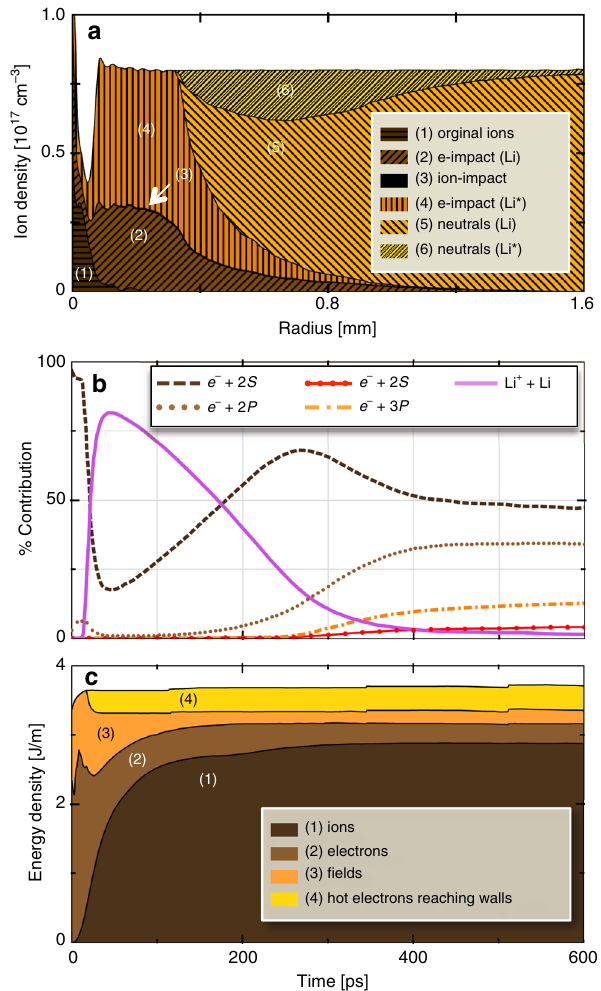
Fig. 5 LCODE simulations of ionization and energy transport channels. a Plot of Li + ion [(1) – (4)] and Li neutral atom [(5) and (6)] density distributions corresponding to electron density distribution at Δ t = 1200 ps in Fig. 4e. Regions (1), (2), and (4) indicate relative contributions of original ions (region 1) and of electron-impact-ionized ground state (2) and excited (4) neutrals, while the barely visible region 3 (black) indicates ion-impact- ionized Li atoms. b Time evolution of indicated impact ionization channels. Ion-impact ionization (solid purple curve) dominates for 50 ≲ Δ t ≲ 160 ps; electron-impact ionization (dark-brown dashed, light-brown dotted, orange dot-dashed, red fi lled-circle curves) dominates for Δ t ≳ 160 ps. c Time evolution of indicated energy transport channels. Hot electrons carry ~10% of the energy deposited in the original wake to the walls in the fi rst ~20 ps (region 4). The expanding plasma column retains the rest without noticeable attenuation throughout the remainder of the simulated period. Electrons (2) and fi elds (3) carry most of the latter energy initially (20 ≲ Δ t ≲ 40 ps), but transfer ~85% of it to radial ion motion (1) within 300 ps. The small jumps evident in curves (2) – (4) are nonphysical. They result from occasionally doubling macro-particle size and halving density as ionization increases particle number, in order to speed up the